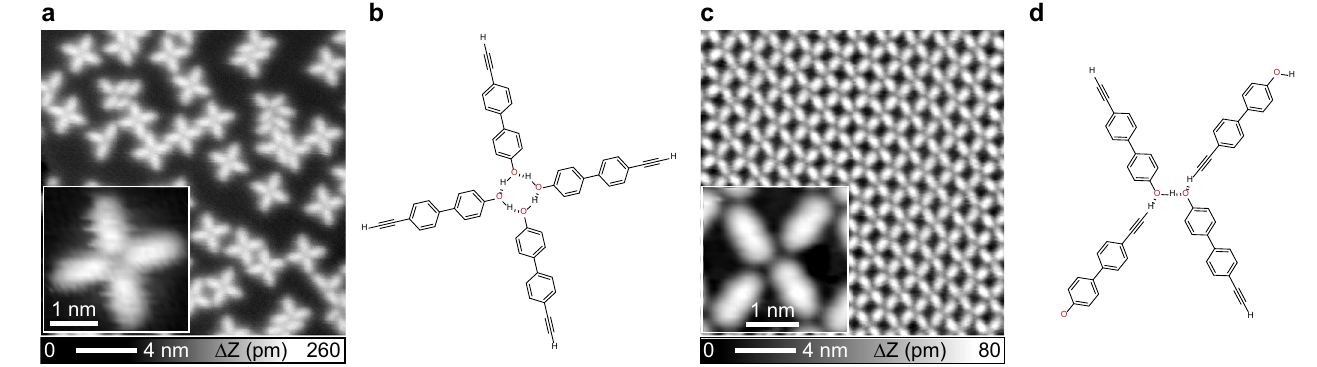
Fig. 2 | Self-assembly structures of EHBP upon deposition on a clean Ag(100) substrate. a , c With the substrate held at 150K and room temperature, respec- tively,eithertetramericunits(insets)orextendednetworksevolve. b , d Themodels